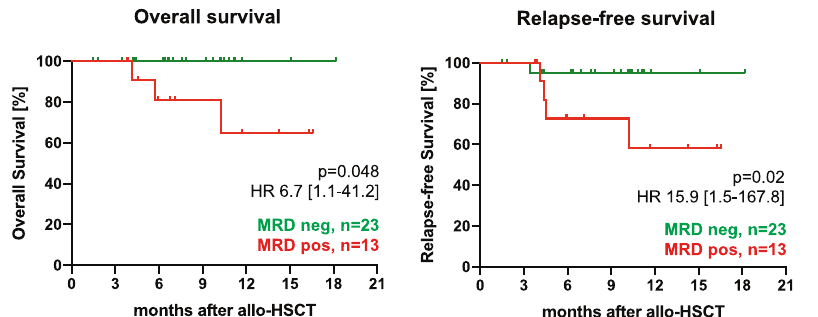
Fig. 4 Posttransplant outcome of patients depending on pre-transplant MRD status assessed by fl ow cytometry (FC). Among patients with CR/CRi ( n = 85) after CPX-351-based induction data on MRD estimated by FC were available for 36 patients (42%) representing MRD negativity in 64% of the patients ( n = 23). The fi gure represents outcome in terms of overall and relapse-free survival for patients with pre- transplant CR MRD − ( n = 23, green line) and CR MRD + ( n = 13, orange